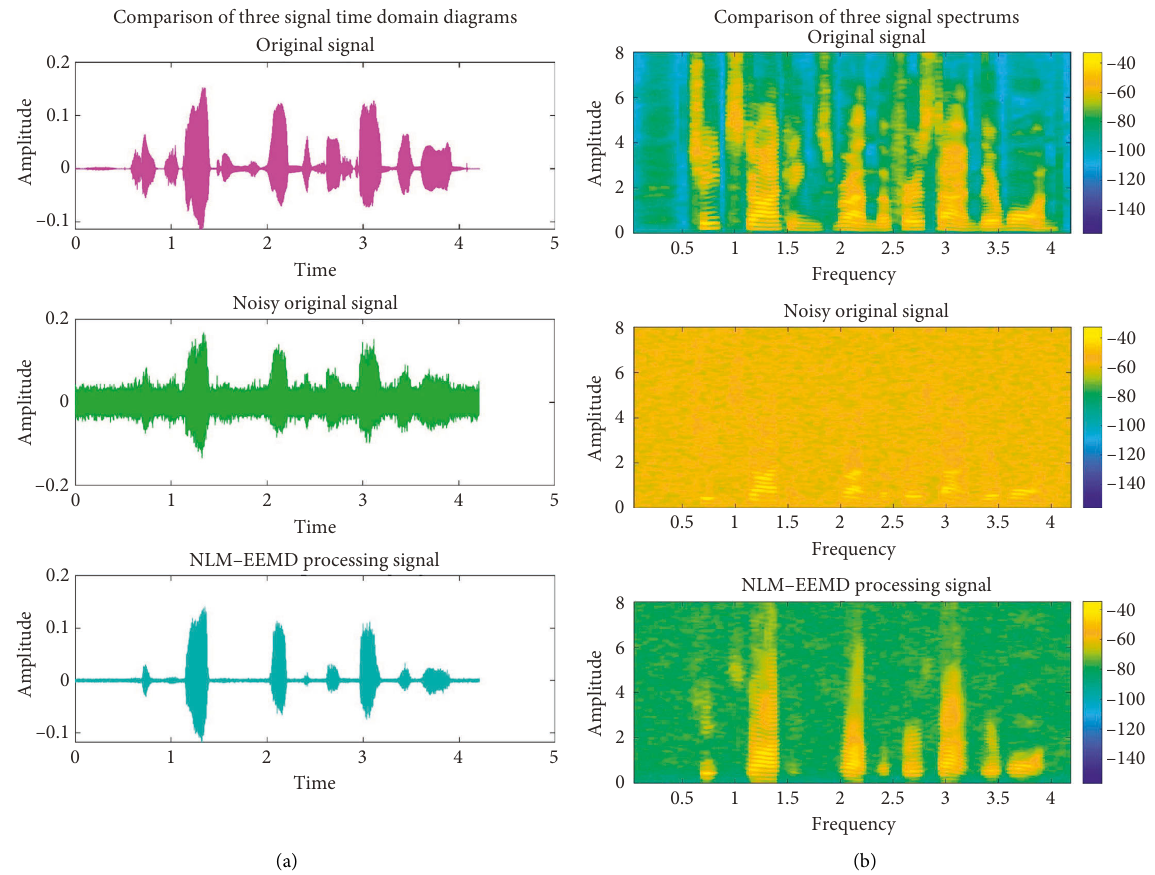
Figure 12: Comparison of original signal, noisy signal, and processed signal. (a) Time domain diagram. (b)